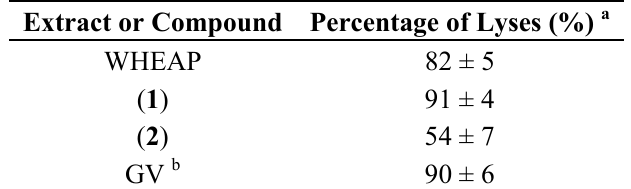
Table 1. Results of the studies against bloodstream, trypomastigote, form of T. cruzi (CL Brener clone). The extract, pure compounds and GV were studied at 250 µg/mL. The experiments were done in